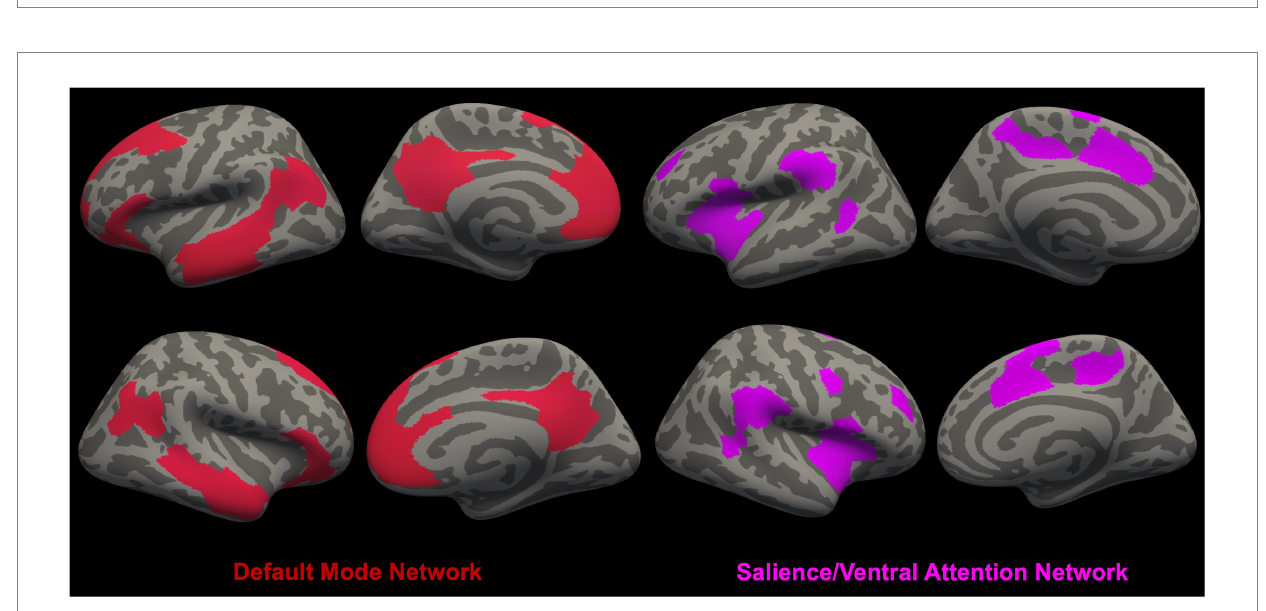
FIGURE 2 Overview of brain networks [i.e., Default Mode Network (DMN) (79) and Salience/Ventral Attention Network (SN/VAN) (80)] (81) that are most commonly found to be involved in functional MRI and brain morphometry research of suicidal thoughts and